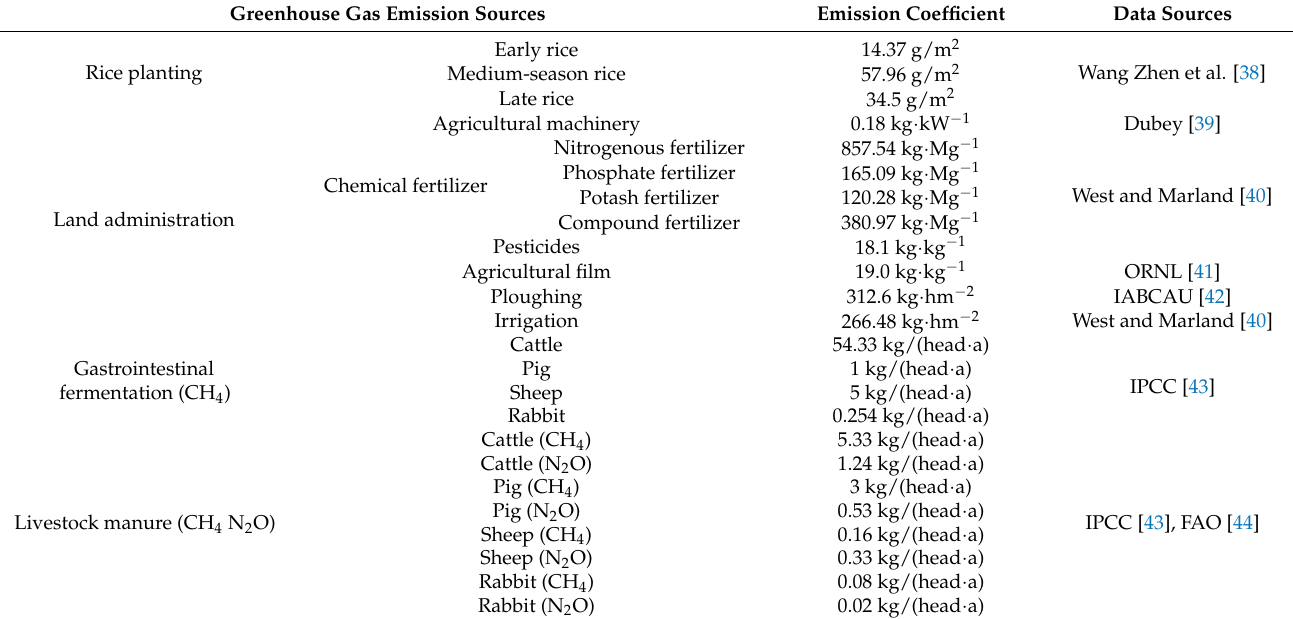
Table 1. Agricultural greenhouse gas emission sources and greenhouse gas emission